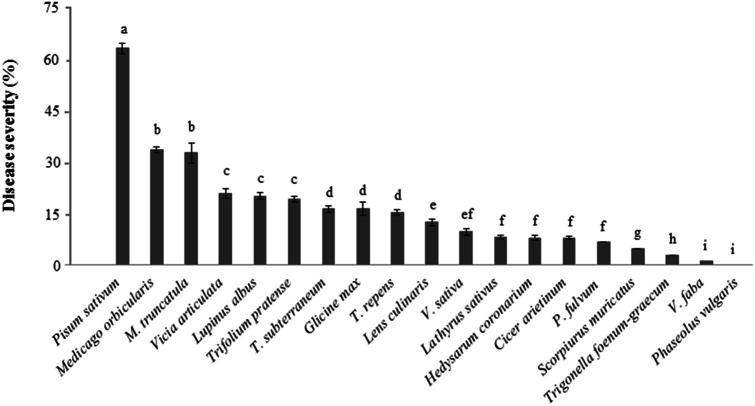
Percentage of disease severity (DS%) measured on foliar organs of different legume species in response to inoculation with D. pinodes isolate Dp-CO-99 under controlled conditions. Averages per species are presented. The bars indicate the standard deviation; different letters indicate significant differences (P = 0.01).